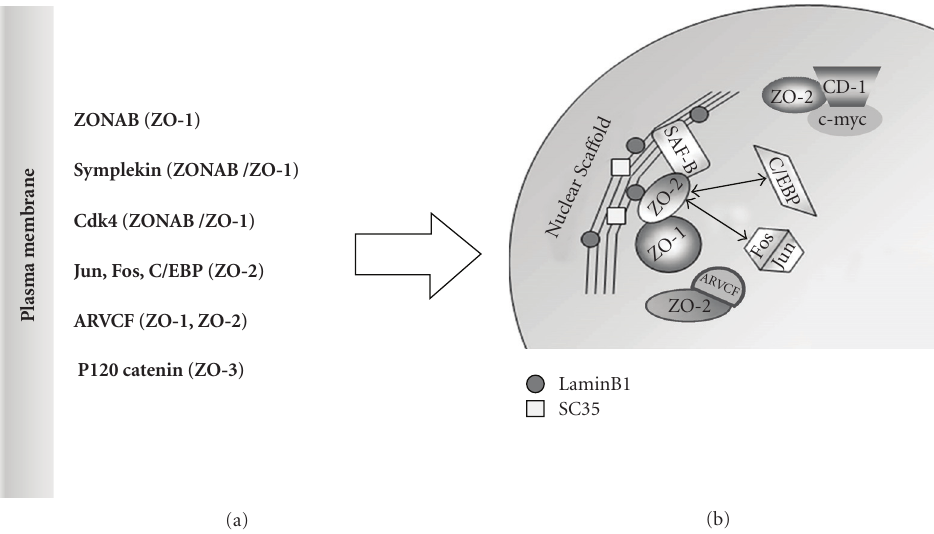
Figure 3: (a) Summary of “dual residency proteins” (locating at the plasma membrane and at the nucleus) associating with ZO-proteins at the junctional site. (b) Nuclear interactions of ZO proteins. ZONAB: ZO-1 associated nucleic acid binding protein; Cdk-4: Cyclin-dependent kinase-4; ARVCF: Armadillo repeat gene deleted in velo-cardio-facial syndrome; SC35: Splicing factor 35.